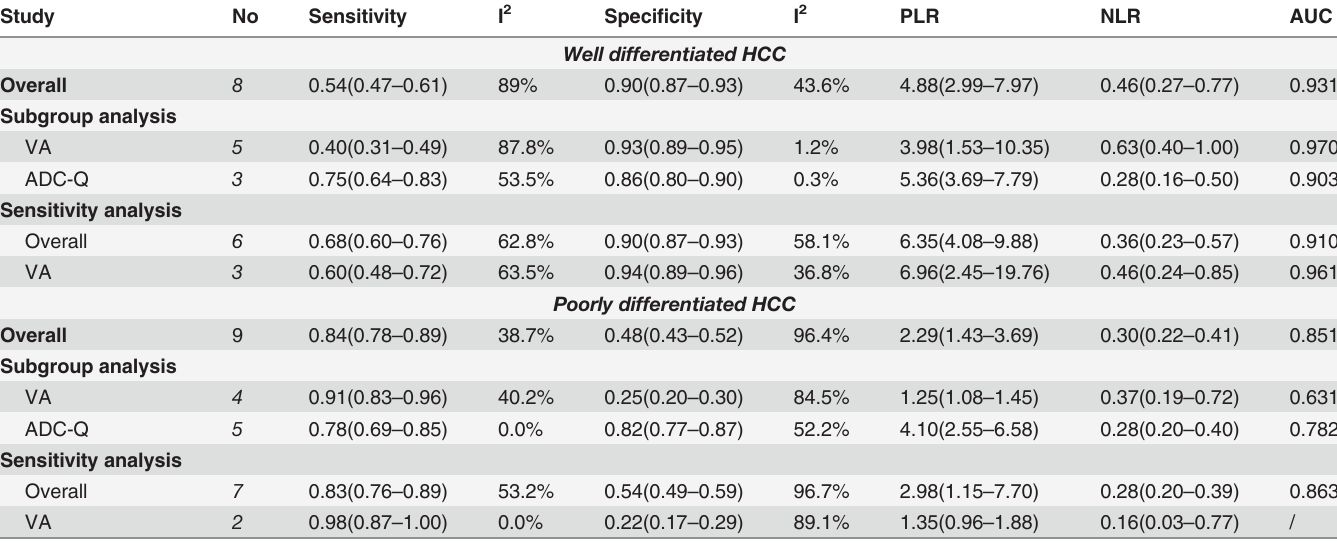
Table 3. Results of subgroup analysis and sensitivity analysis.